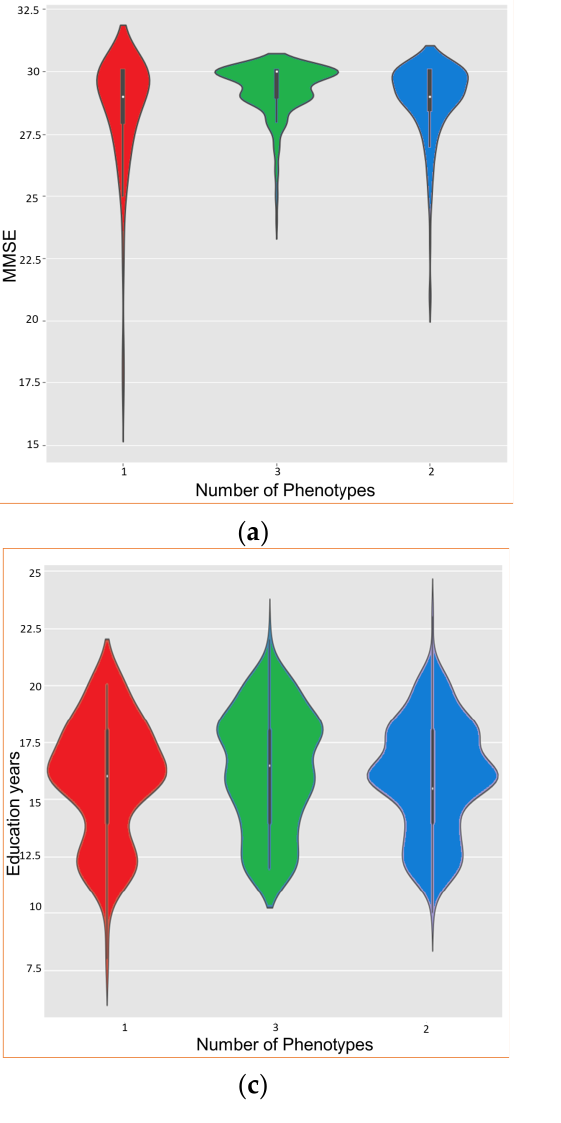
Figure 10. Epigenetics analysis with violin graphs. Differences between phen1, phen2, and phen3 in ( a ) MMSE, ( b ) smoking years, ( c ) education years, and ( d ) age. In red is phen1, in green is phen2, and in blue is phen3.